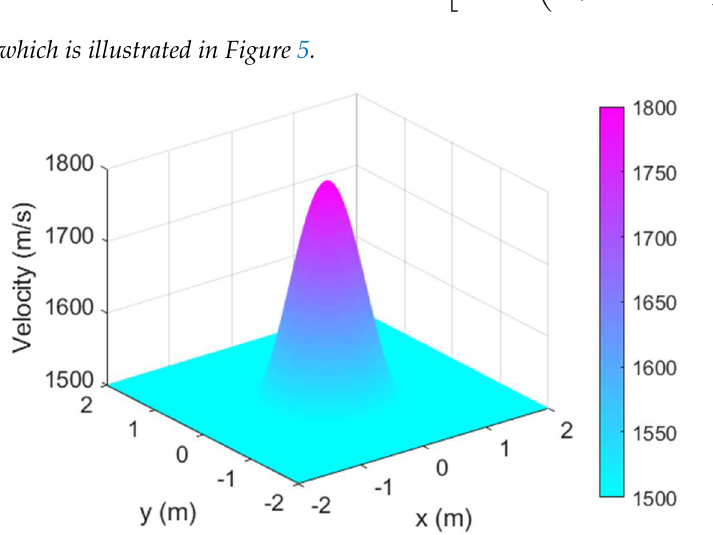
Figure 5. Velocity distribution in a heterogeneous domain for Example 2.